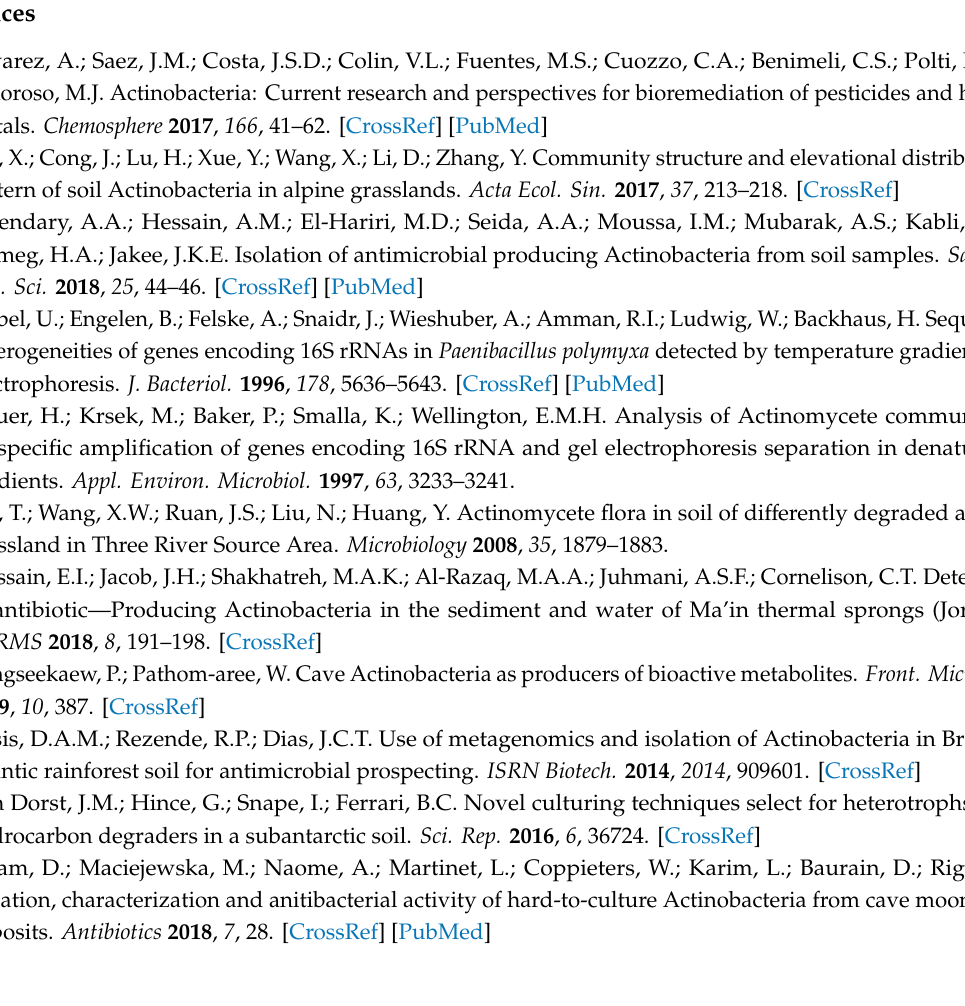
Figure A4. Cluster analysis by UPGMA similarity of Actinobacteria DGGE banding patterns between soil samples (NC—non-cultivated, C—cultivated). The number before C and NC indicates the soil sample number.